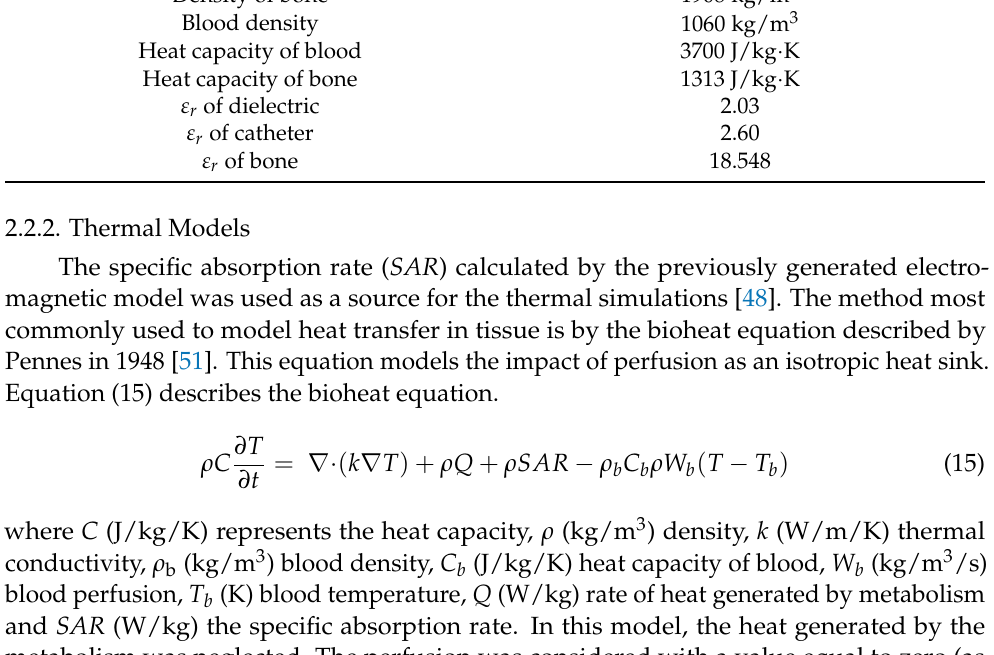
Table 1. Dielectric and thermal properties for analyzed electro-thermal model